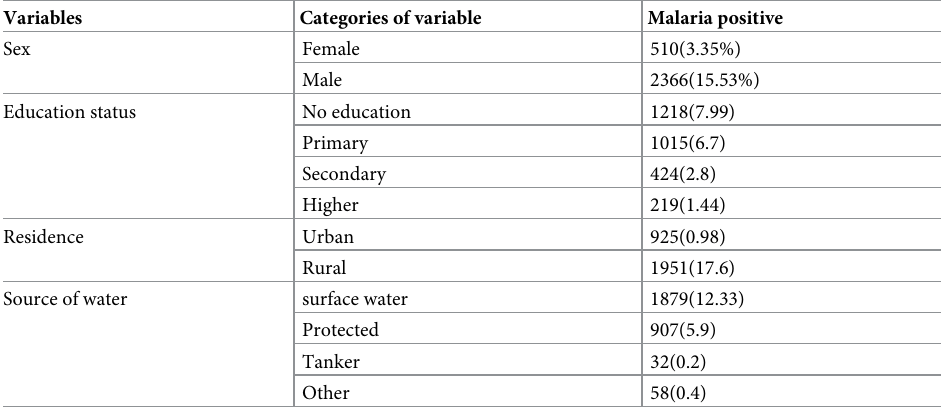
Table 1. Socio-demographic characteristics of malaria in Ethiopia.